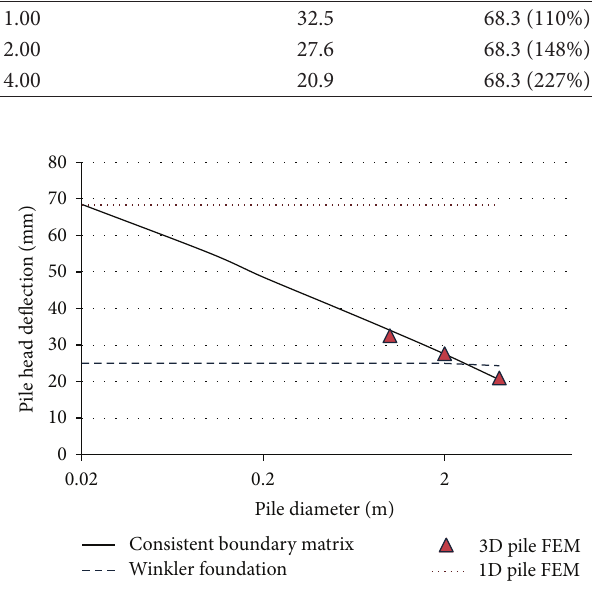
T 2: Variation of pile head displacement versus pile diameter in different linear analysis methods with constant EI for the pile. Pile diameter (m)